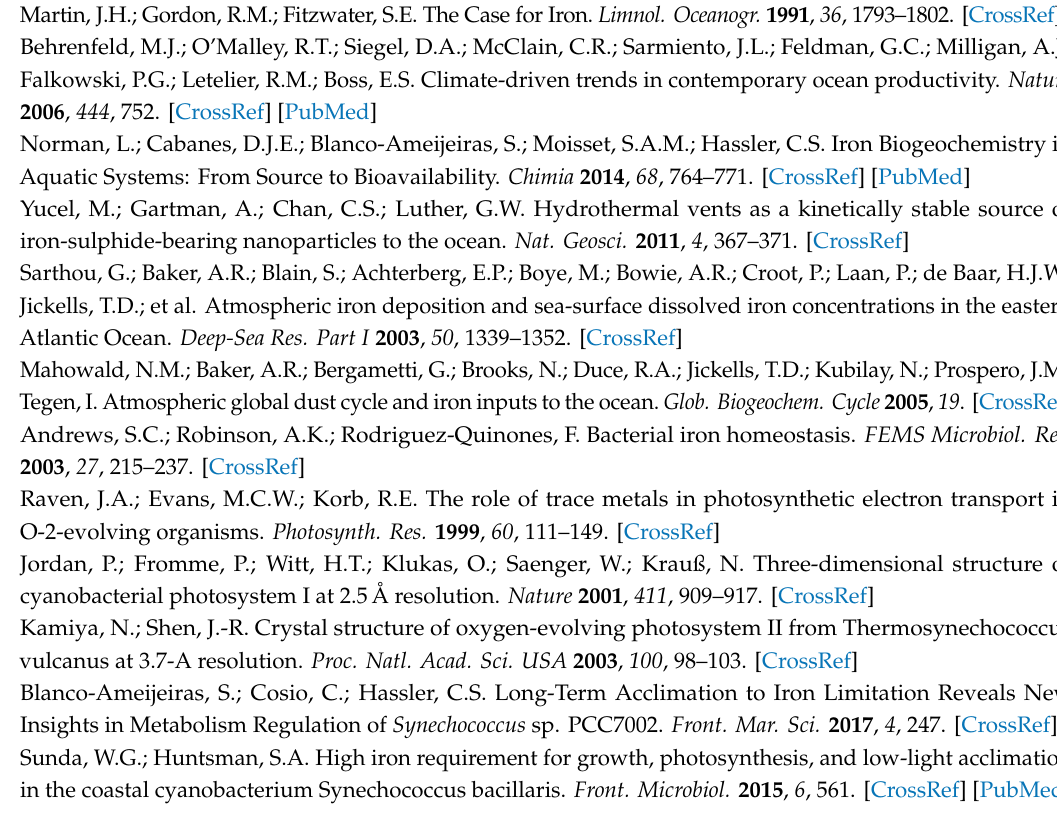
s1, Figure S1: Total iron concentrations, Table S1: Sampling days, Table S2: Visual Minteq Output and percentage